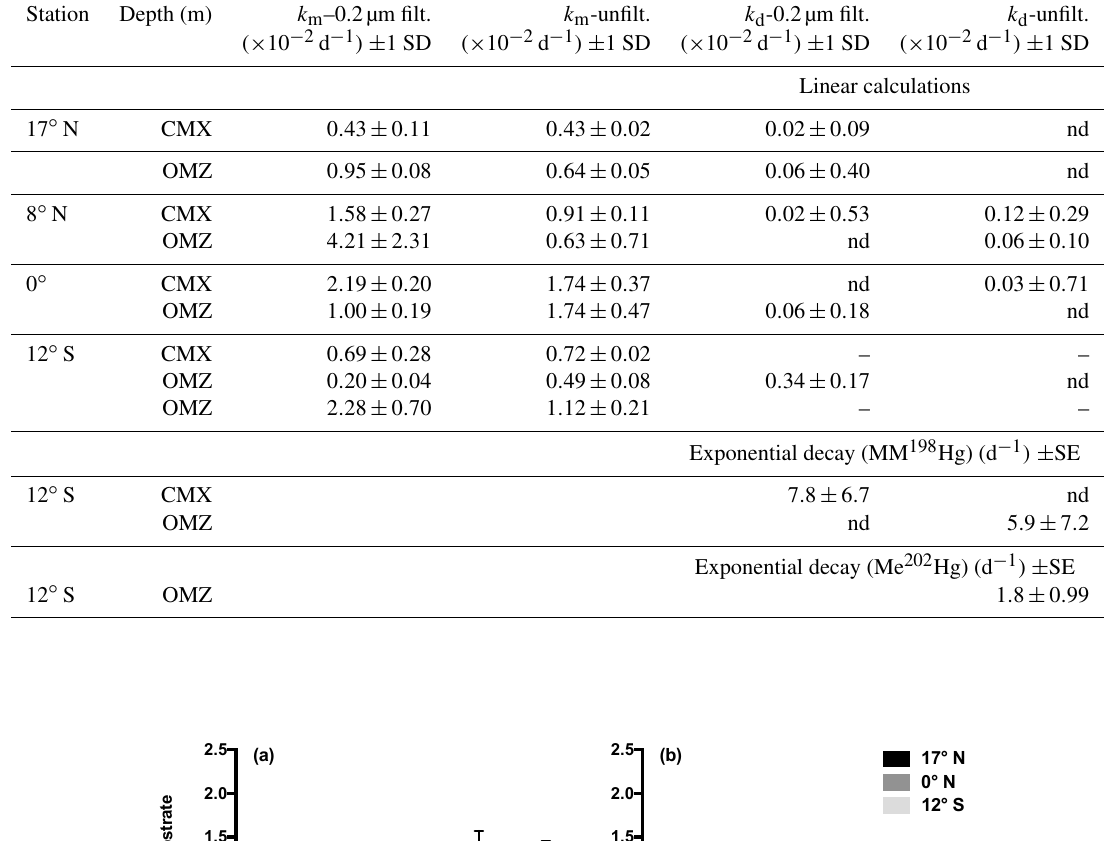
Table 2. Potential methylation ( k m ) and demethylation ( k d ) rate constants from triplicate bottle incubations of tropical Pacific waters in filtered and unfiltered water. Linear calculations were made from differences between t 0 and t 24 hour time points of added MM 198 Hg. Exponential decay was calculated from 36h time course incubations.